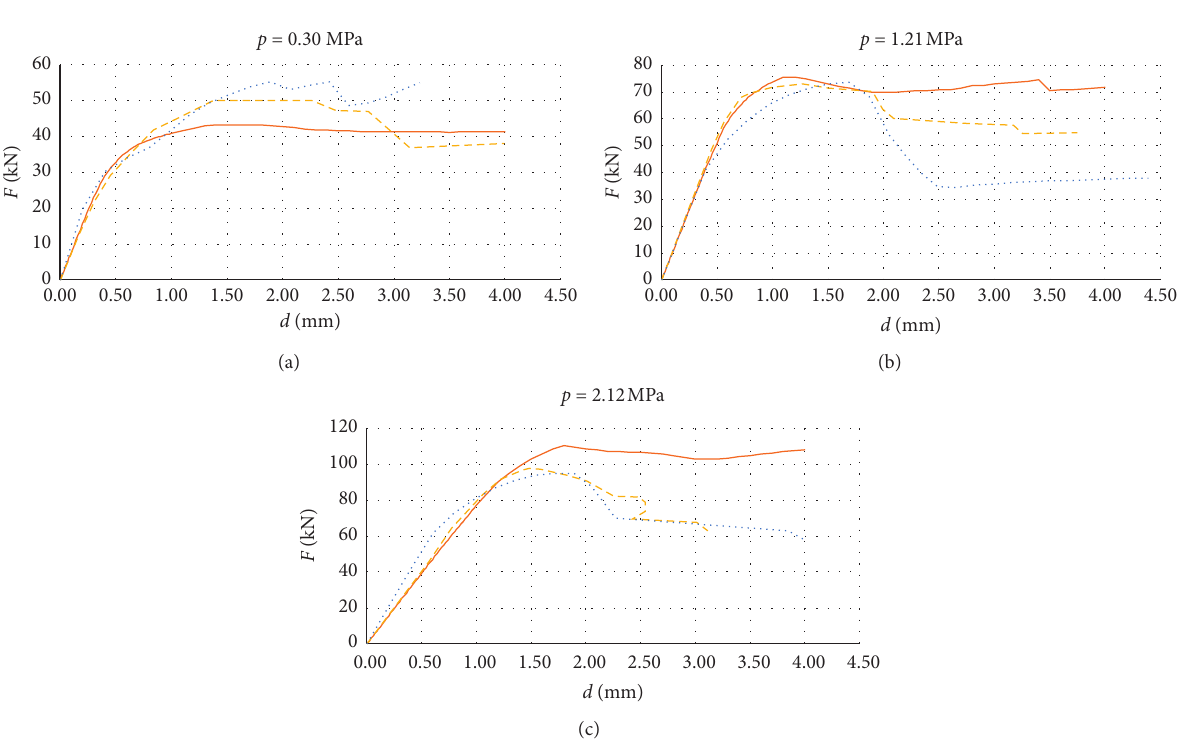
Figure 5: Pushover curves of the numerical shear tests with varying compression. Continuous line for refined rigid block model, dotted line for FE-TSRCM, and dashed line for laboratory test